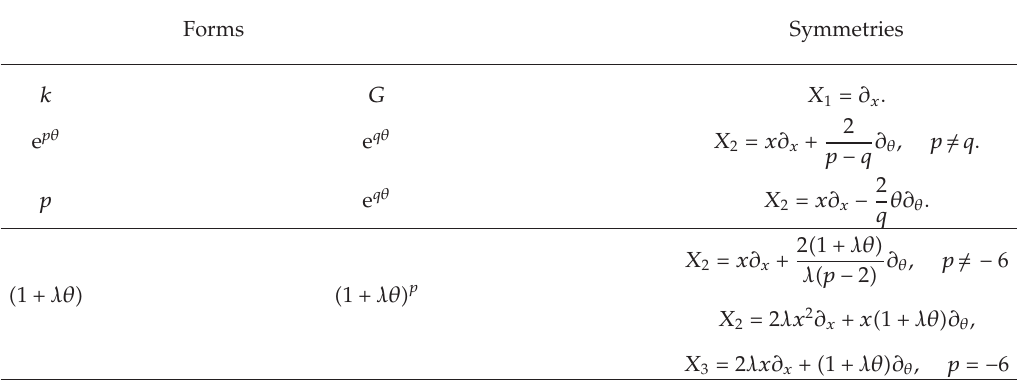
Table 1: Extensions of the principal Lie